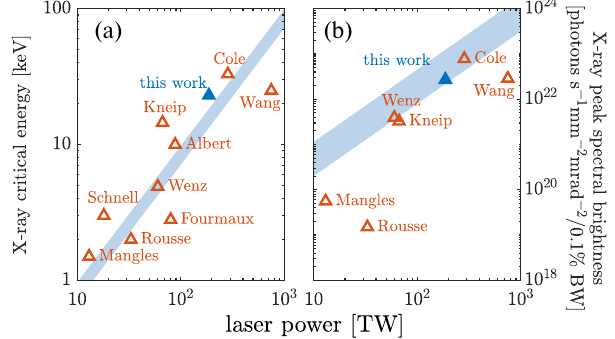
FIG. 5. Scaling of x-ray radiation with laser power from various experiments [7,9,10,29 – 34]: (a) E corresponds to Eqs. (7) and (8) for n